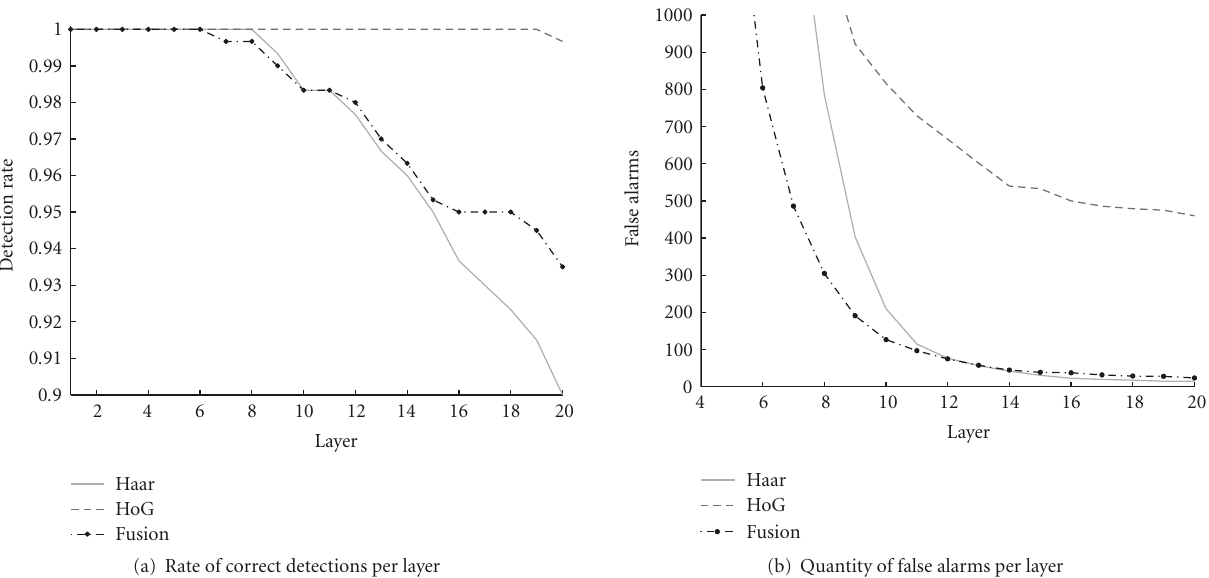
Figure 10: Behaviour of detection as a function of cascade for a detector with 3000 negative examples.